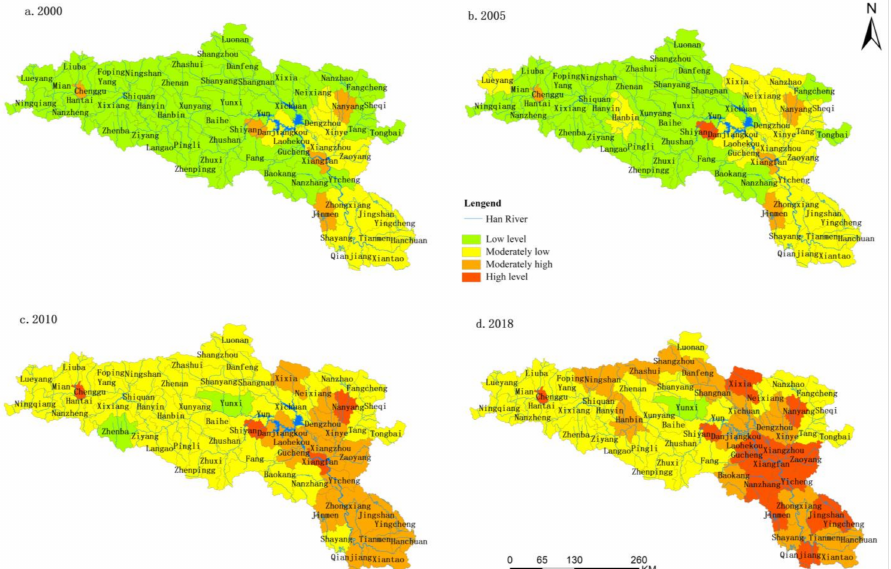
Figure 2. Spatial change trend of urbanization. The ( a – d ) stand for 2000, 2005, 2010, and 2018 respectively. Low level indicates that the indices of the three subsystems were all lower than the average value of the whole basin. Moderately low level indicates that any one of the three subsystem indices was higher than the average value of the whole basin. Moderately high level indicates that any two indices of the three subsystems were higher than the average value of the whole basin. High level indicates that the indices of the three subsystems were all higher than the average value of the whole